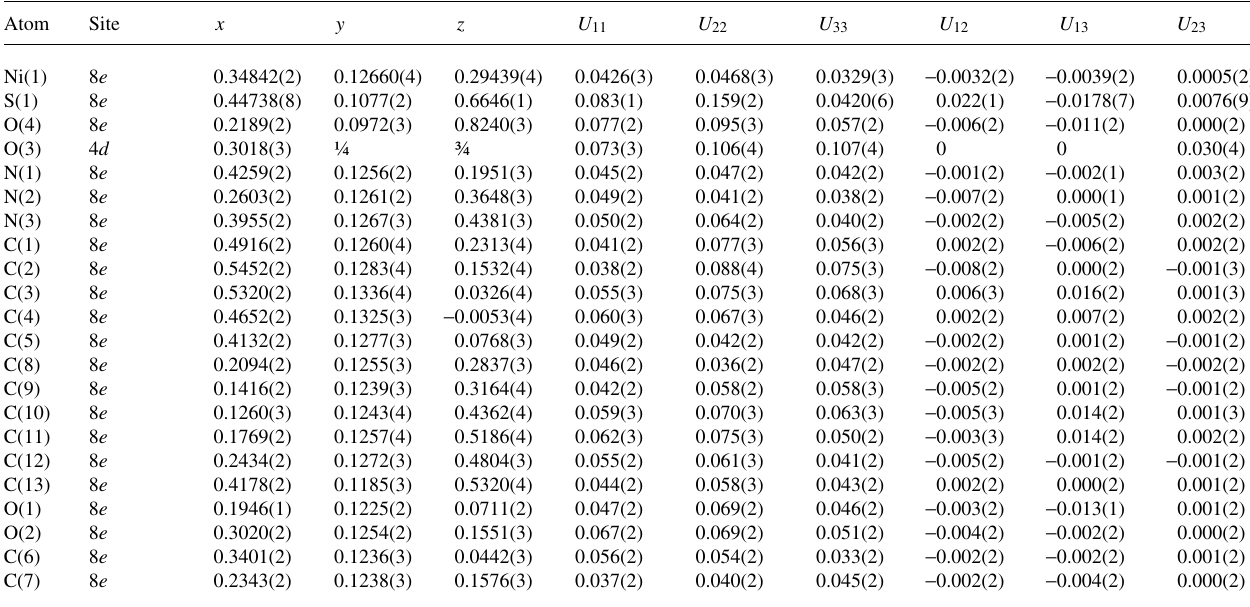
Table 3. Atomic coordinates and displacement parameters (in Å 2 ) .